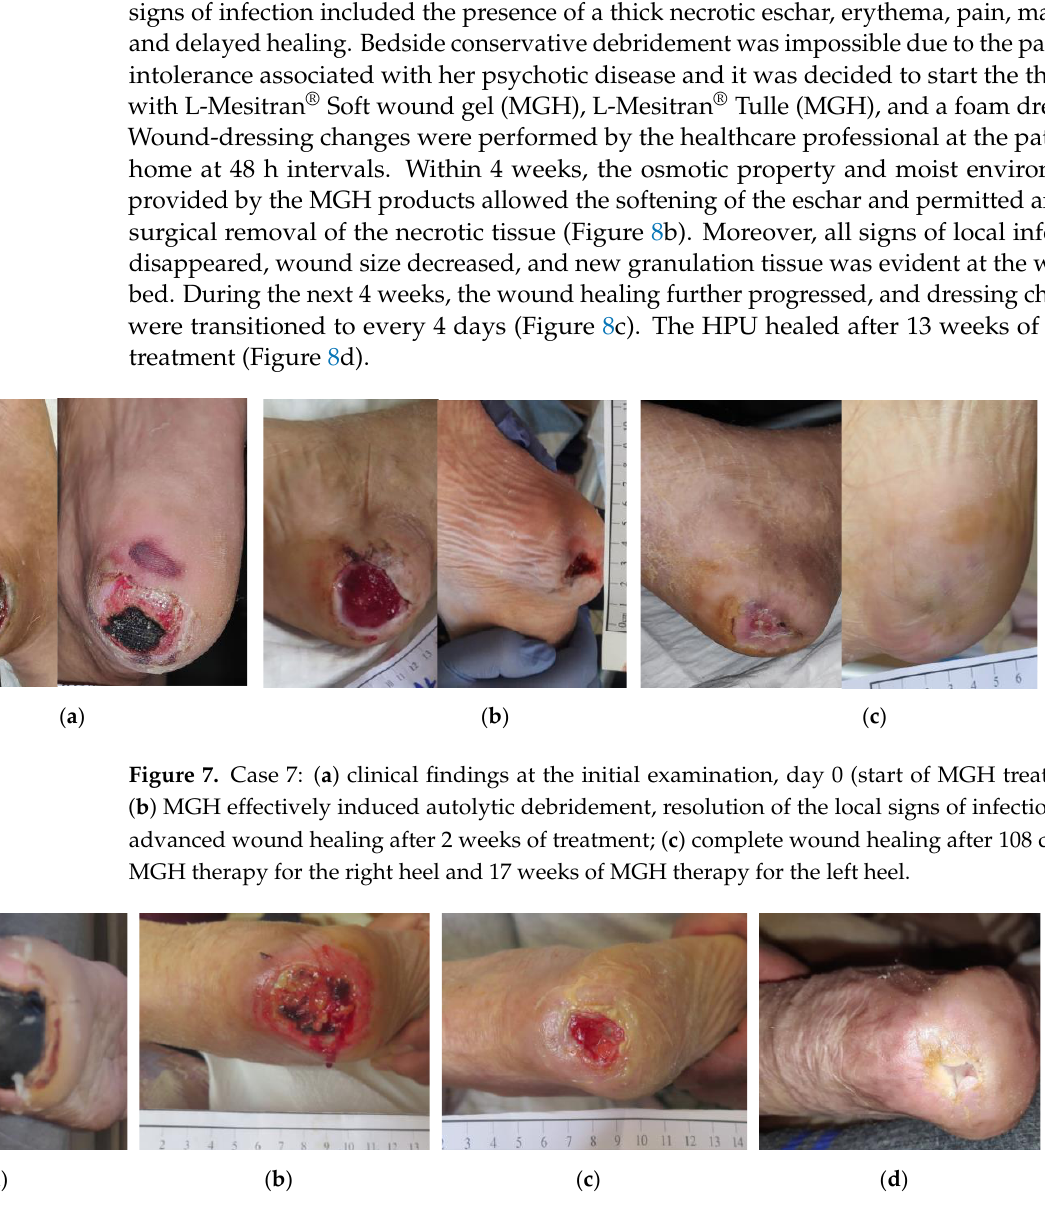
Figure 8. Case 8: ( a ) clinical findings at initial examination, day 0 (start of MGH treatment); ( b ) the MGH products allowed the softening of the eschar and permitted an easy surgical removal of the necrotic tissue with concomitant advanced wound healing after 4 weeks of treatment; ( c ) elimination